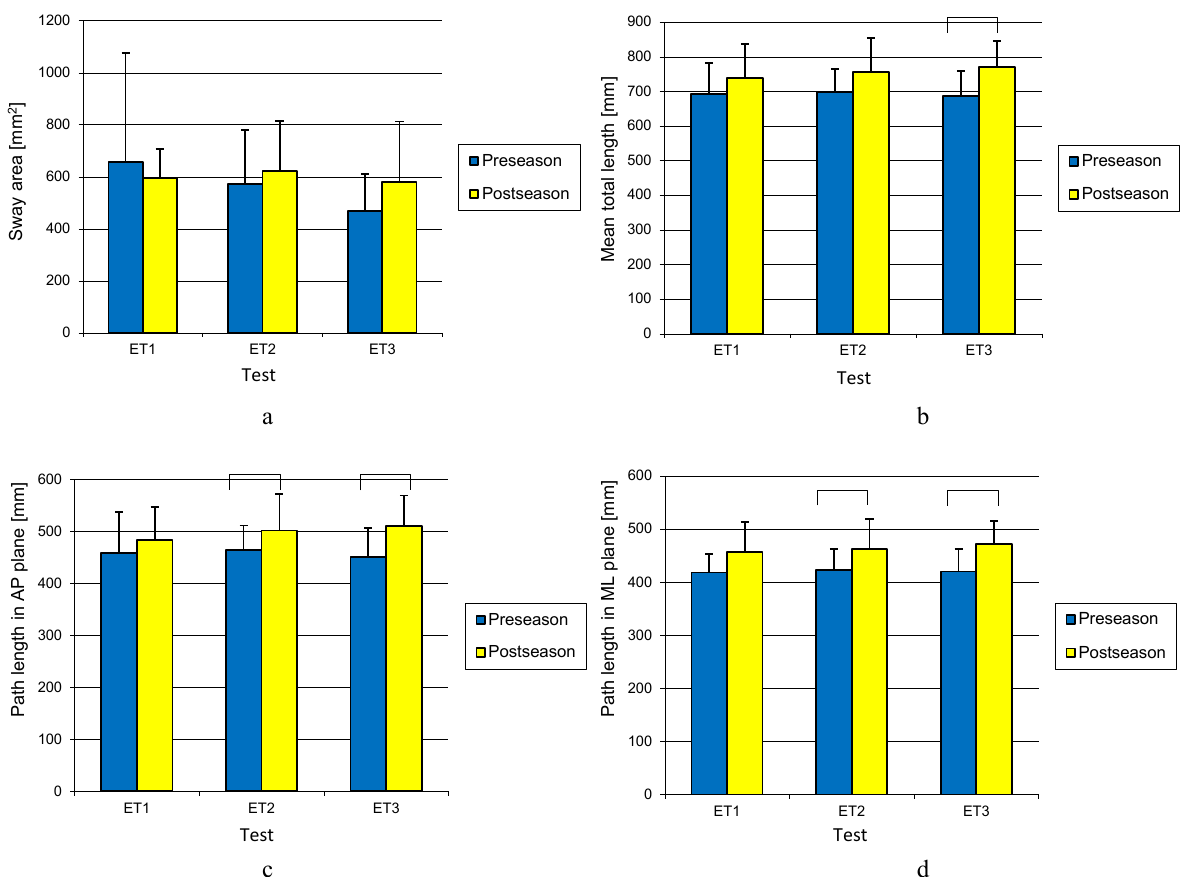
Figure 2. Group mean values (± S.D.) of sway area, total length of stabilogram, length of stabilogram in sagittal plane and length of stabilogram in frontal plane in soccer players in postseason and preseason. Statistically significant differences are indicated with *p<0.05,